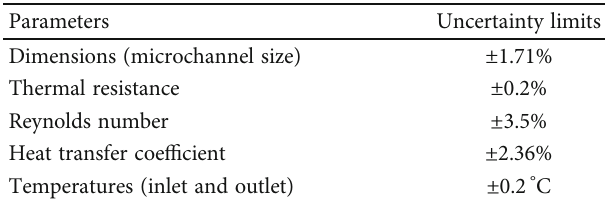
Table 3: Parameters